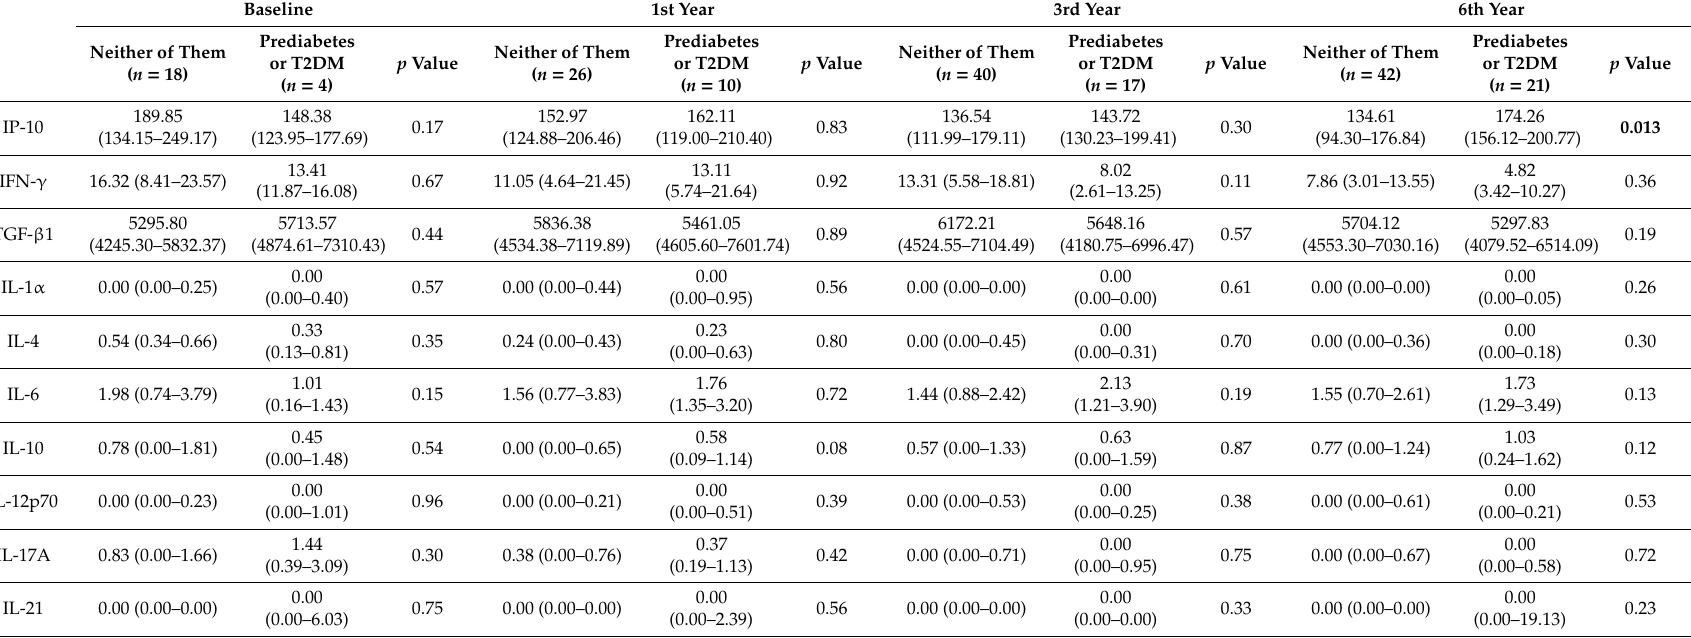
Table 3. Levels of the 10 kinds of cytokines / chemokines in the patients with “prediabetes or type 2 diabetes mellitus (T2DM)” or “neither of them” at the given time